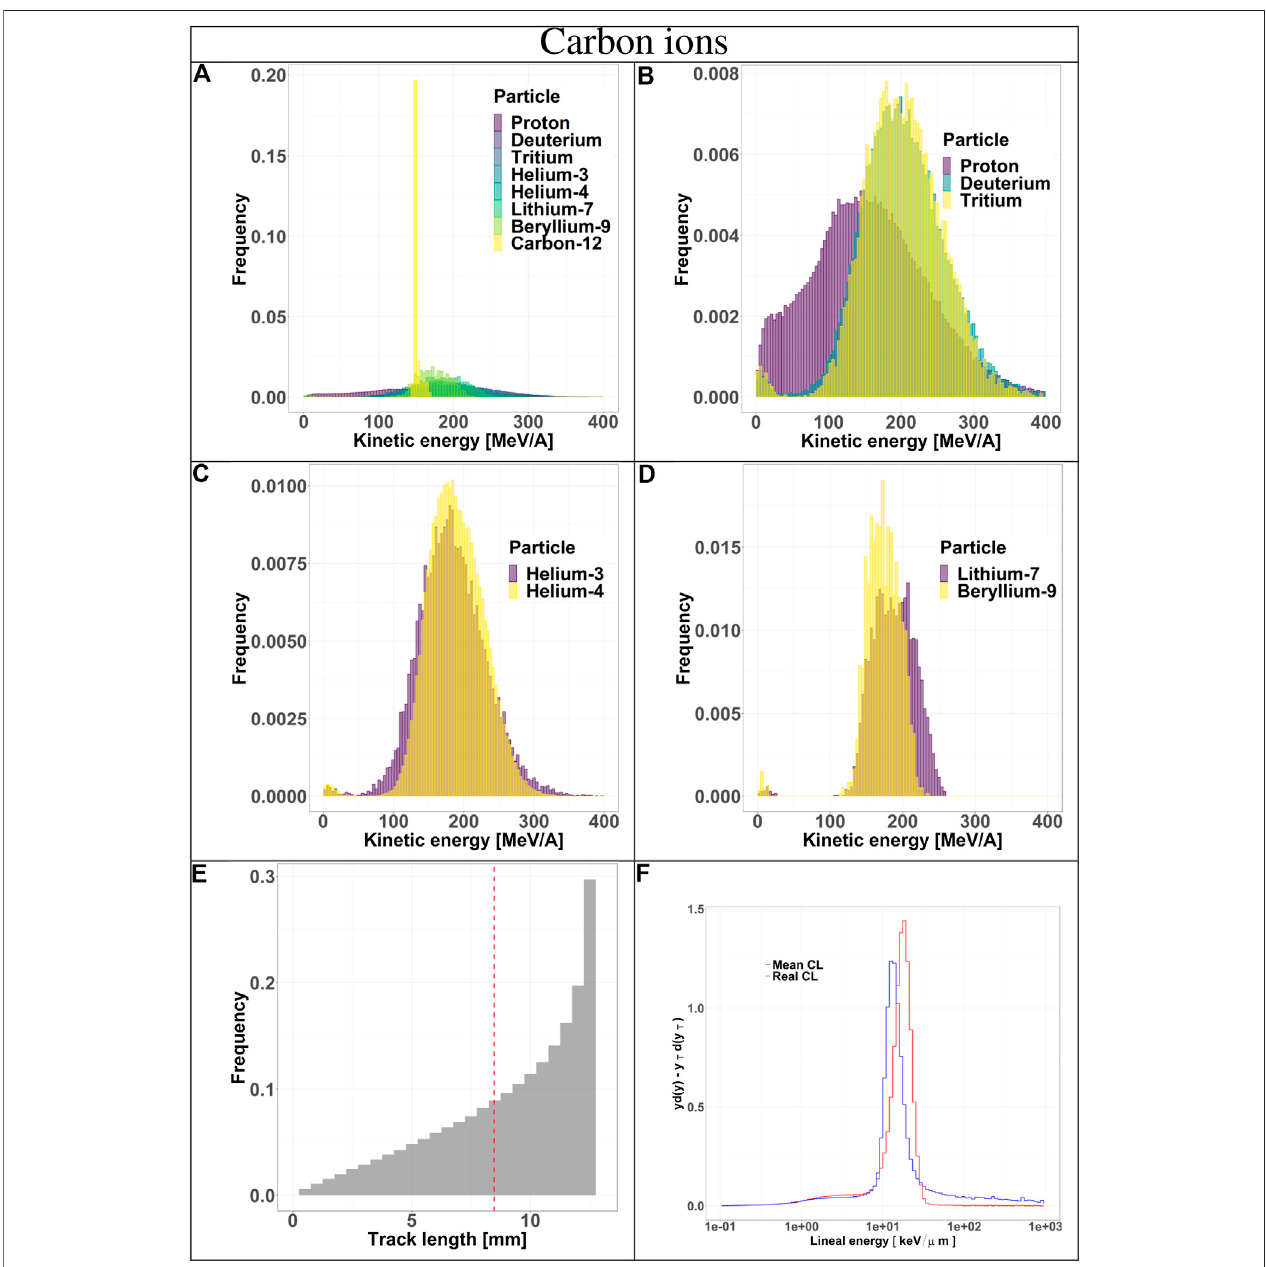
FIGURE 4 | Characterization of the radiation fi eld generated by 290 MeV/u carbon ions after traversing 10.74 cm of water and seen by the TEPC. Panels (A – D) : kinetic energy spectra of the most abundant components of the radiation fi eld including and excluding the primary ions. Panel (E) : track length distribution of all the particles detected by the TEPC. The mean chord length at 8.47 mm is marked with a red dotted line. Panel (F) : microdosimetric yd(y) spectra obtained with the mean chord length approximation (red line) and microdosimetric y T d ( y T ) spectra obtained using the real chord length values (blue